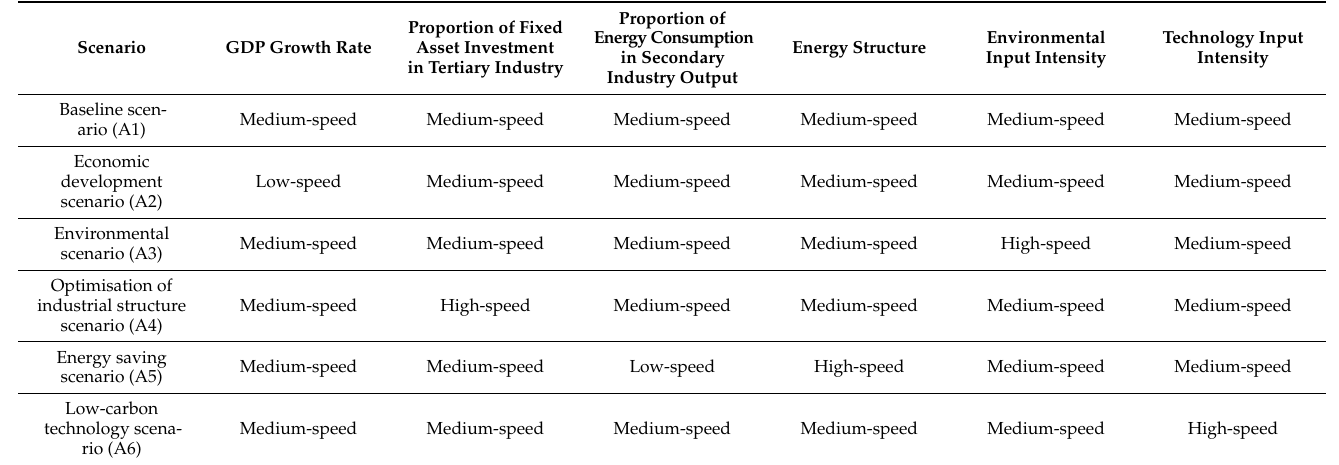
Table 6. Single regulation of carbon emissions scenario setting.